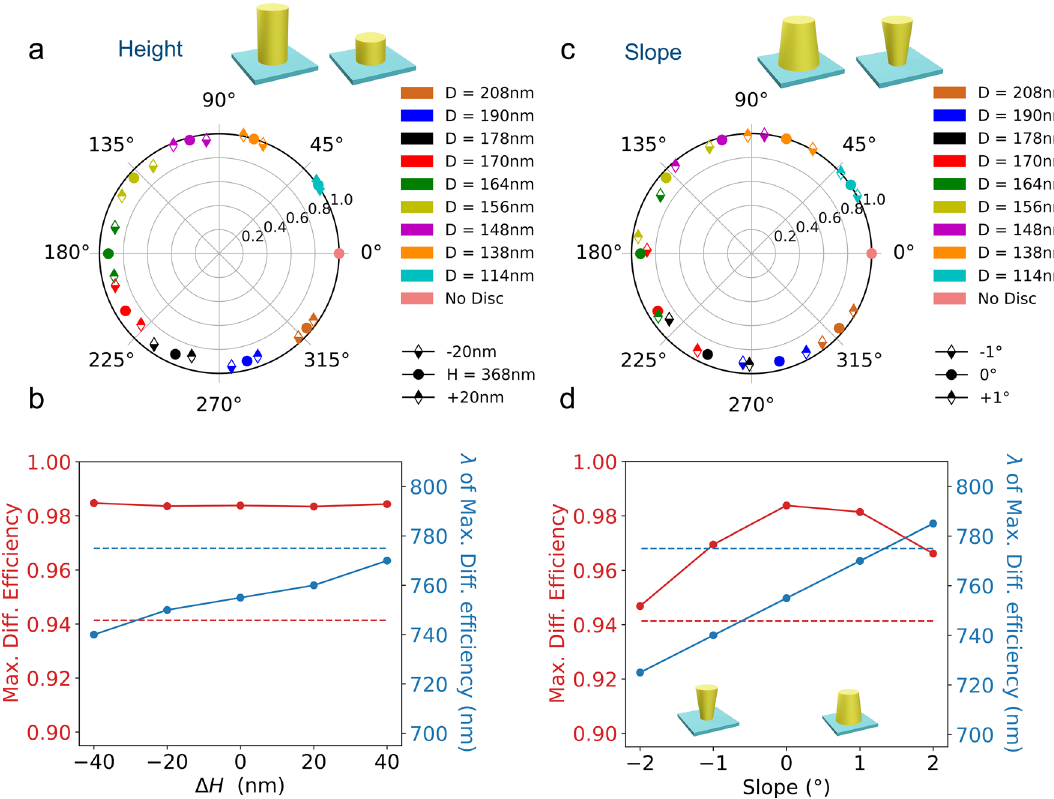
Figure 5. ( a ) Transmission and dephasing induced by an array of silicon nanocylinders on a normally incident (cid:31) = 750 nm plane wave as a function of a change in height for the ten selected geometries. ( b ) Diffraction efficiency and wavelength of max. diffraction efficiency as a function of difference in height. ( c ) Transmission and dephasing induced by an array of silicon nanocylinders on a normally incident (cid:31) = 750 nm plane wave as a function of a change in lateral slope for the ten selected geometries. ( d ) Diffraction efficiency and wavelength of max. diffraction efficiency as a function of the slope of the cylinder side. The red (resp. blue) dotted lines show the measured values of maximum diffraction efficiency and corresponding